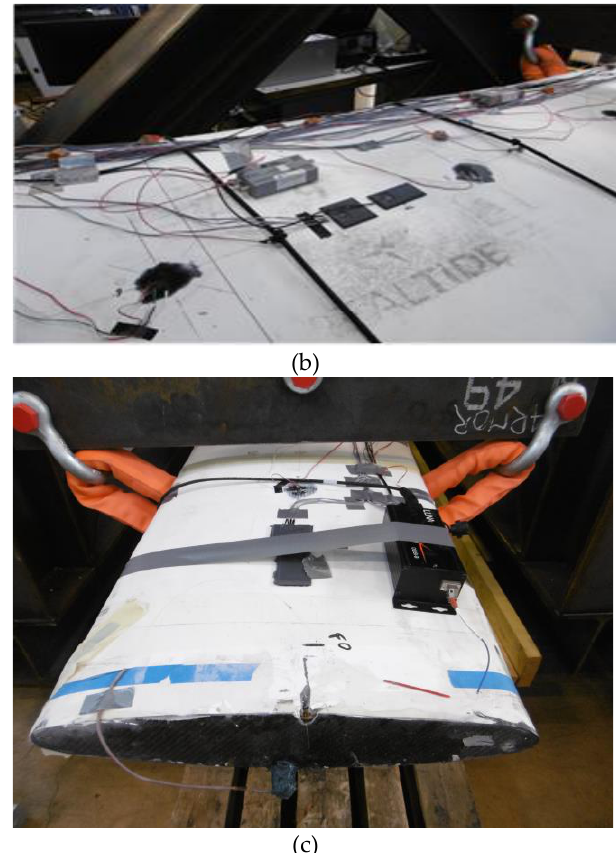
Fig. 14. Blade instrumentation. (a) Displacement transducers, (b) Acoustic emission and EnerOcean transducers. (c) Blade tip showing optical fibre connections and interrogator box. Table 2 summarizes the data channels and the five data acquisition systems used to record the